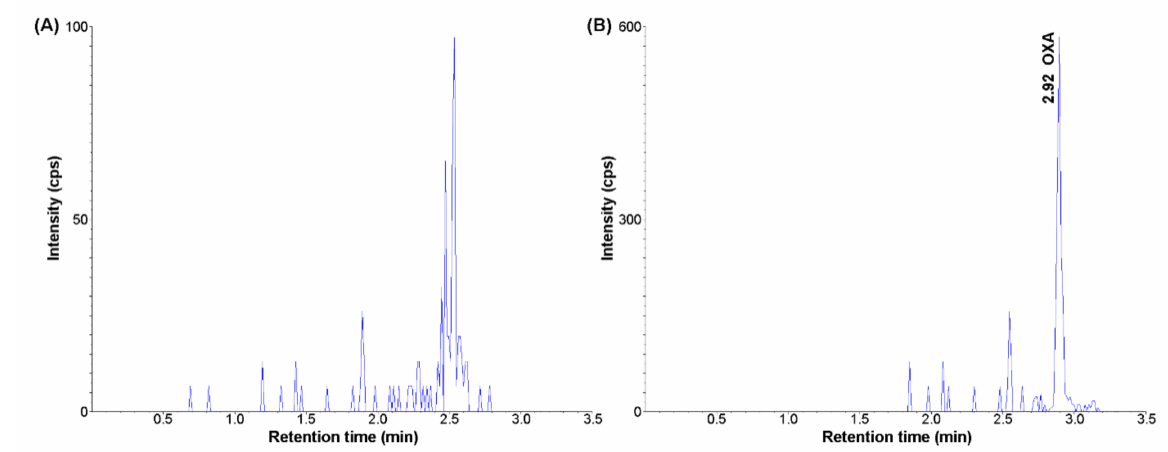
Figure 2. Representative MRM chromatograms of orexin A: ( A ) blank vitreous body; ( B ) blank vitreous body spiked with orexin A (1 pg/mL) (UHPLC-MS/MS